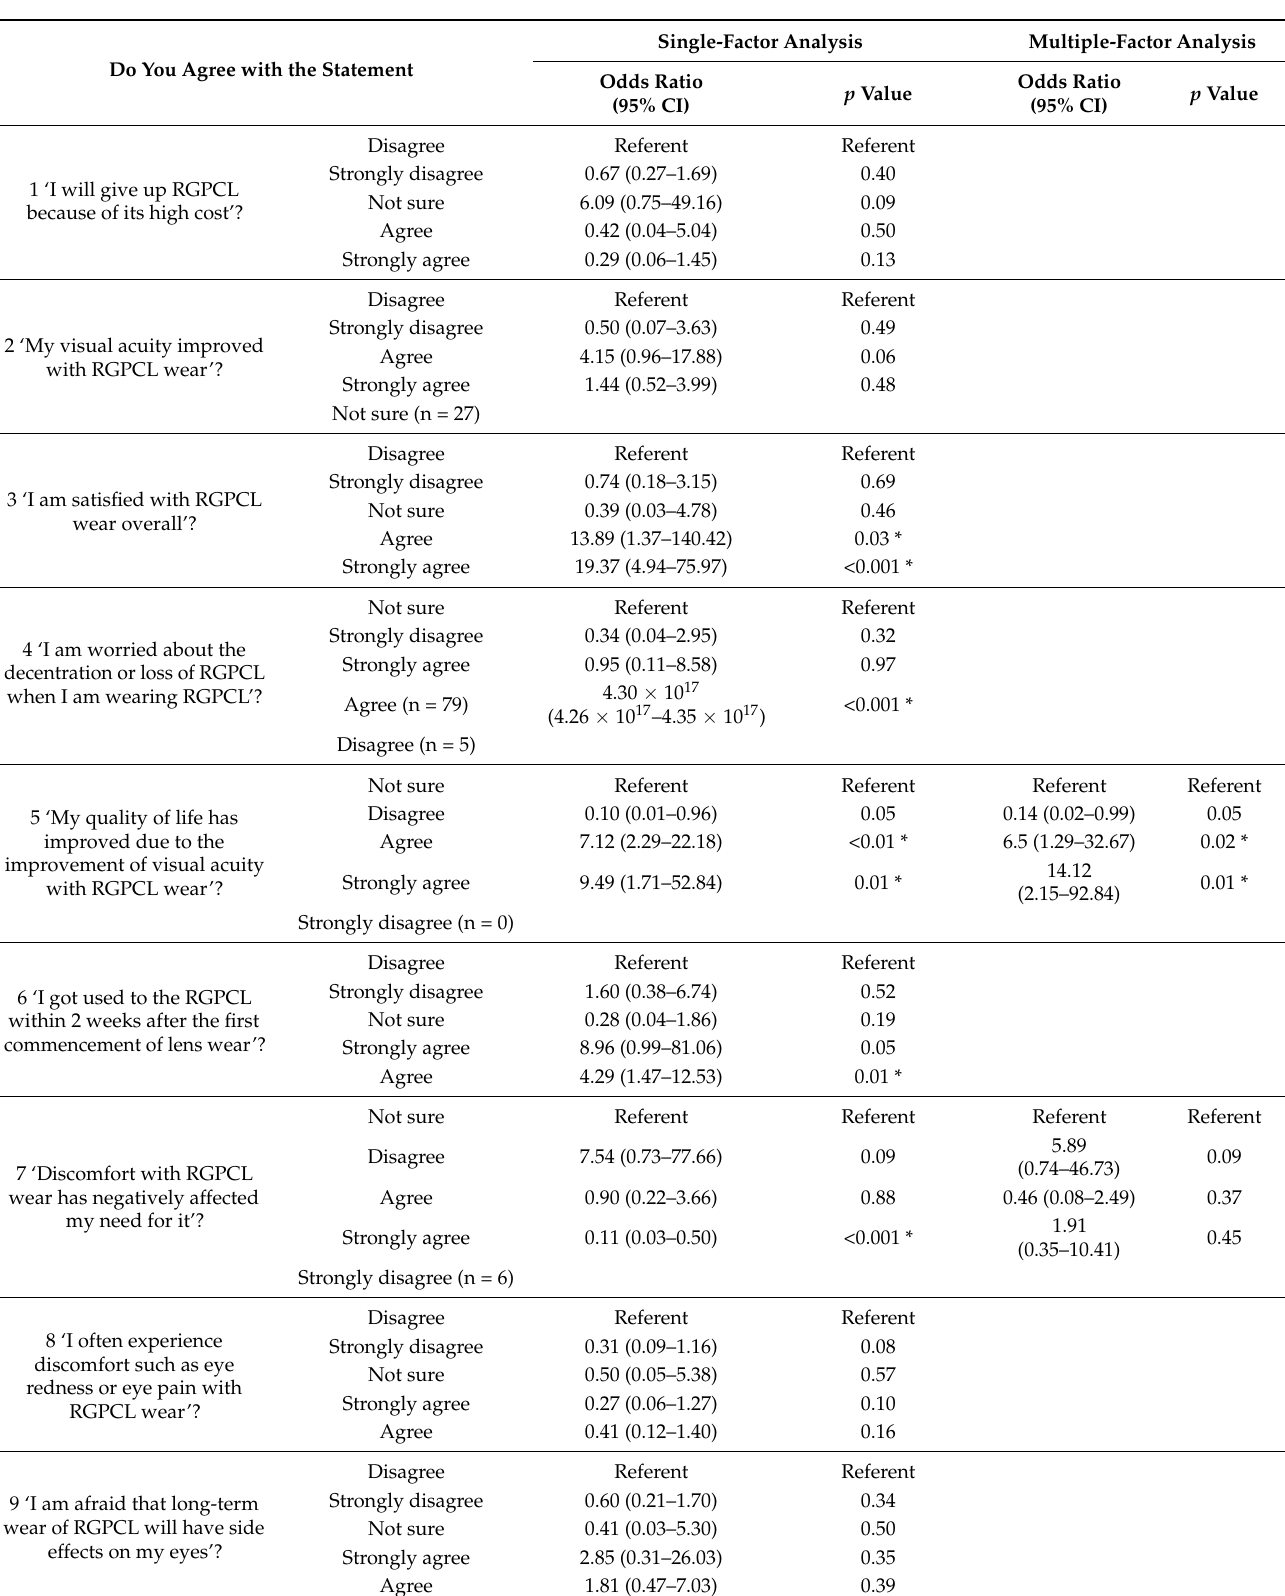
Table 6. Generalised estimating equation results of the answers to the questionnaire survey from the